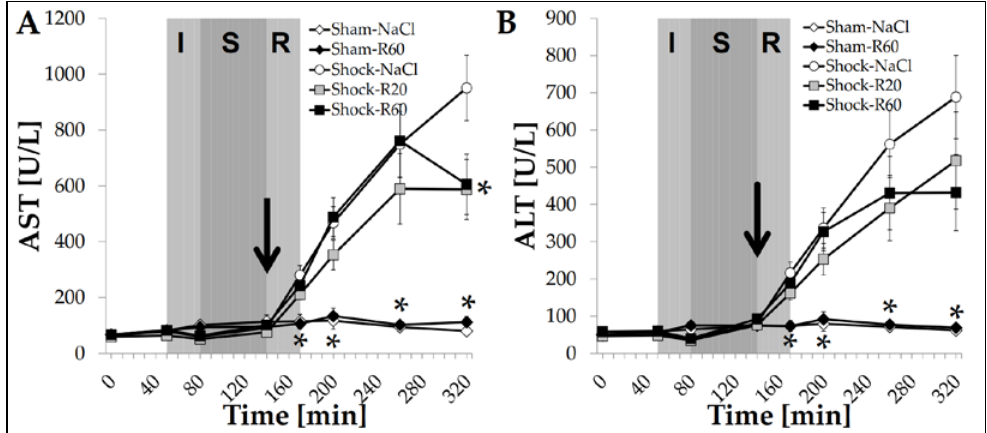
Figure 4. Effect of continuous intravenous infusions of solvent-free low-dose resveratrol on plasma aspartate aminotransferase and alanine aminotransferase activities subsequent to severe hemorrhagic shock in rats. Rats underwent severe hemorrhage (30 min shock induction, I; 60 min shock phase, S), then were resuscitated (R, within 30 min) with the withdrawn blood and LR equal to twice the volume of the withdrawn blood (30 min) in the absence (Shock-NaCl) or presence of resveratrol (20 or 60 μg/kg × h until the end of the experiment; Shock-R20, Shock-R60) and observed for a further 150 min. Sham animals received either pure 0.9% NaCl solution (Sham-NaCl) or the higher resveratrol dose (Sham-R60). Aspartate aminotransferase (AST, A ) and alanine aminotransferase (ALT, B ) activities were determined in plasma from arterial blood samples as obtained at the time points indicated. Shown are mean values ± SEM ( n = 8 animals per group). * p < 0.05 (vs. Shock-NaCl). The arrow indicates the start of the resveratrol infusions.